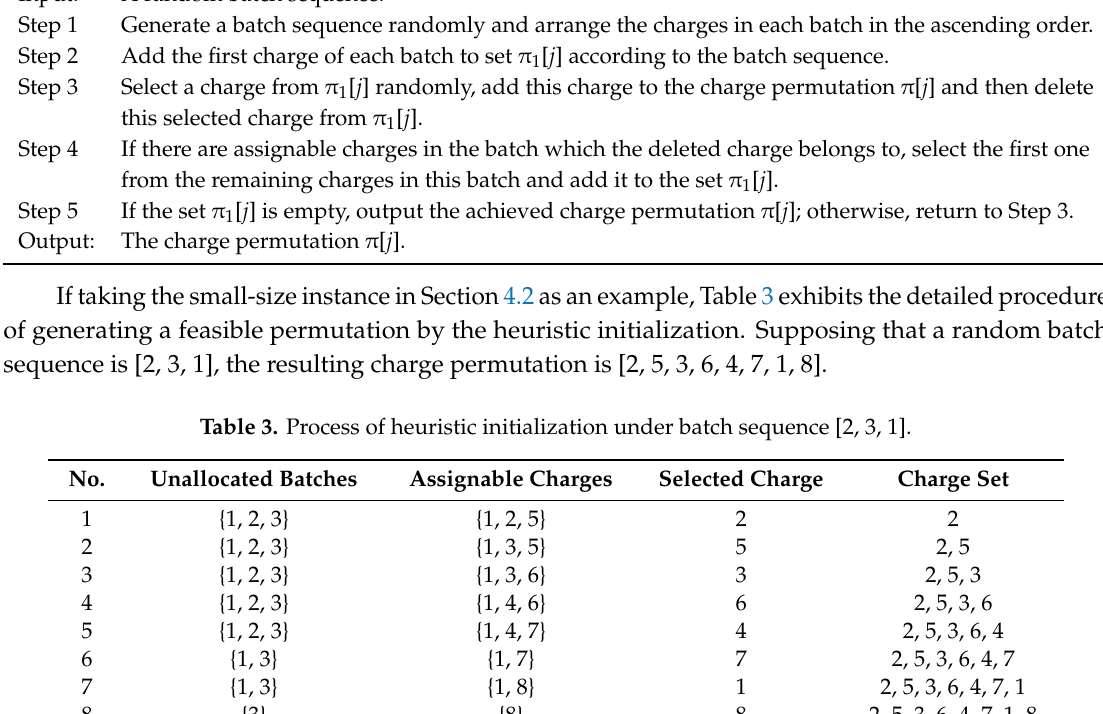
Table 3. Process of heuristic initialization under batch sequence [2, 3, 1].